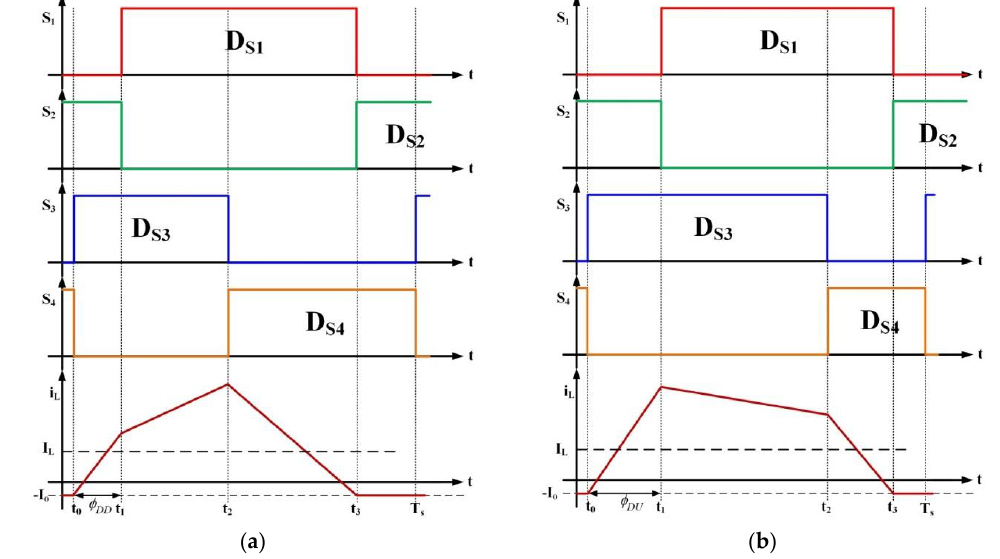
Figure 3. The gating signals and inductor current waveforms during discharging operation. ( a ) Buck mode; ( b ) Boost mode.